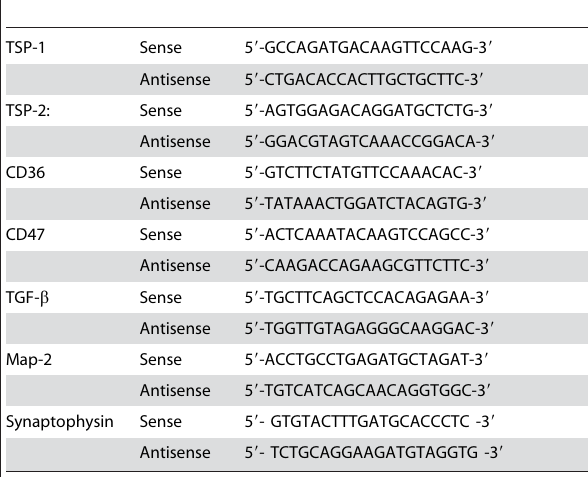
Table 1. The primers Real-time RT-PCR.